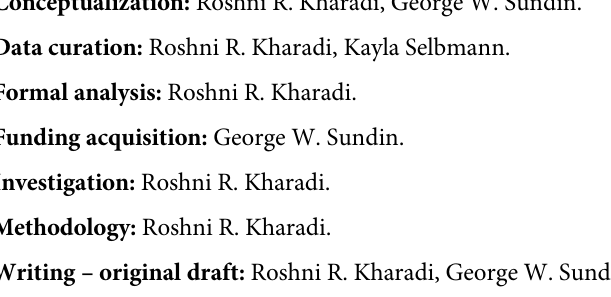
S1 Fig. Graph summarizing the RNAseq and q-RT-PCR based examination of fold changes in the expression of representative genes (from both RNAseq studies) A) atpG and fliG in Ea1189 Δ 12 relative to WT Ea1189 and B) EAM_2517 and EAM_1085 in Ea1189 Δ 8 over expressing edcA-E individually relative to Ea1189 Δ 8. Error bars represent standard error of the